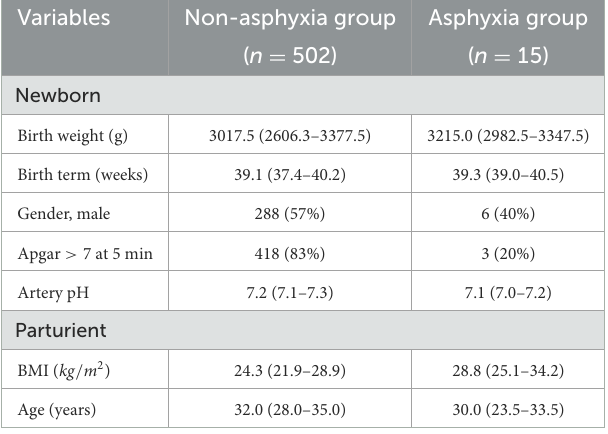
TABLE 1 Characteristics of asphyxia and non-asphyxia groups. Data are expressed in n ( % ) or median (interquartile